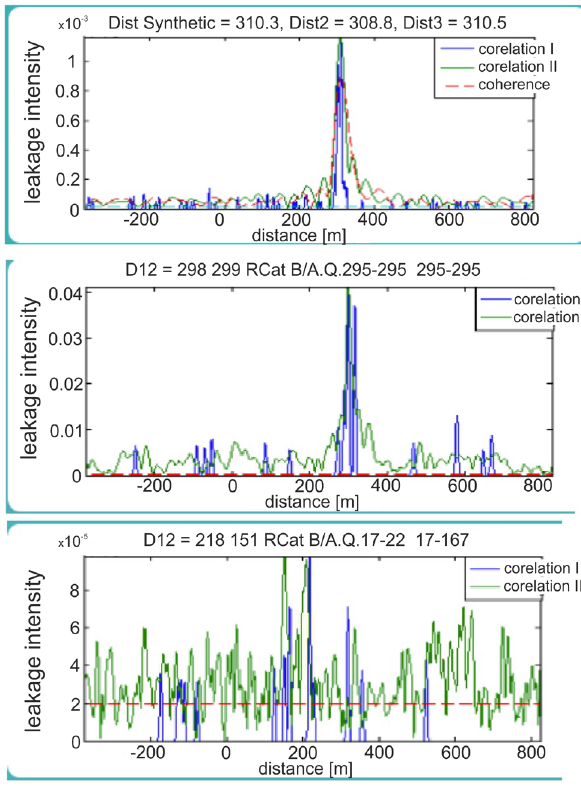
Figure 4: Graphical representation of the correlation of leakages on the tested section of the pipeline in Shamir street.